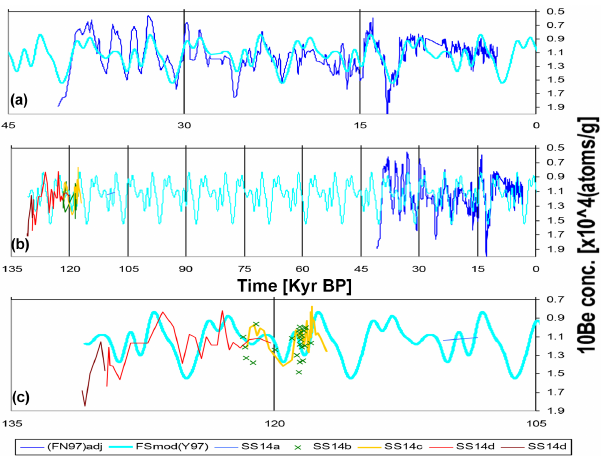
Figure 2. Data and modeling of 10 Be isotope concentration in Greenland ice cores. (a) Data and an FS model of 10 Be isotope for the past 40kyr provided by Finkel and Nishiizumi (1997, FN97) after being detrended and demodulated (see Supplement). (b) The model, shown in (a) , is extrapolated covering the last 135kyr, and the (Sturevik-Storm et al., 2014, SS14) data are included for com- parison. (c) A zoom of (b) for a detailed comparison of the extrap- olated FS model and the SS14 data. Please note that a maximum match implies a SS14 temporal adjustment, or time bias, of 2.5kyr going back in